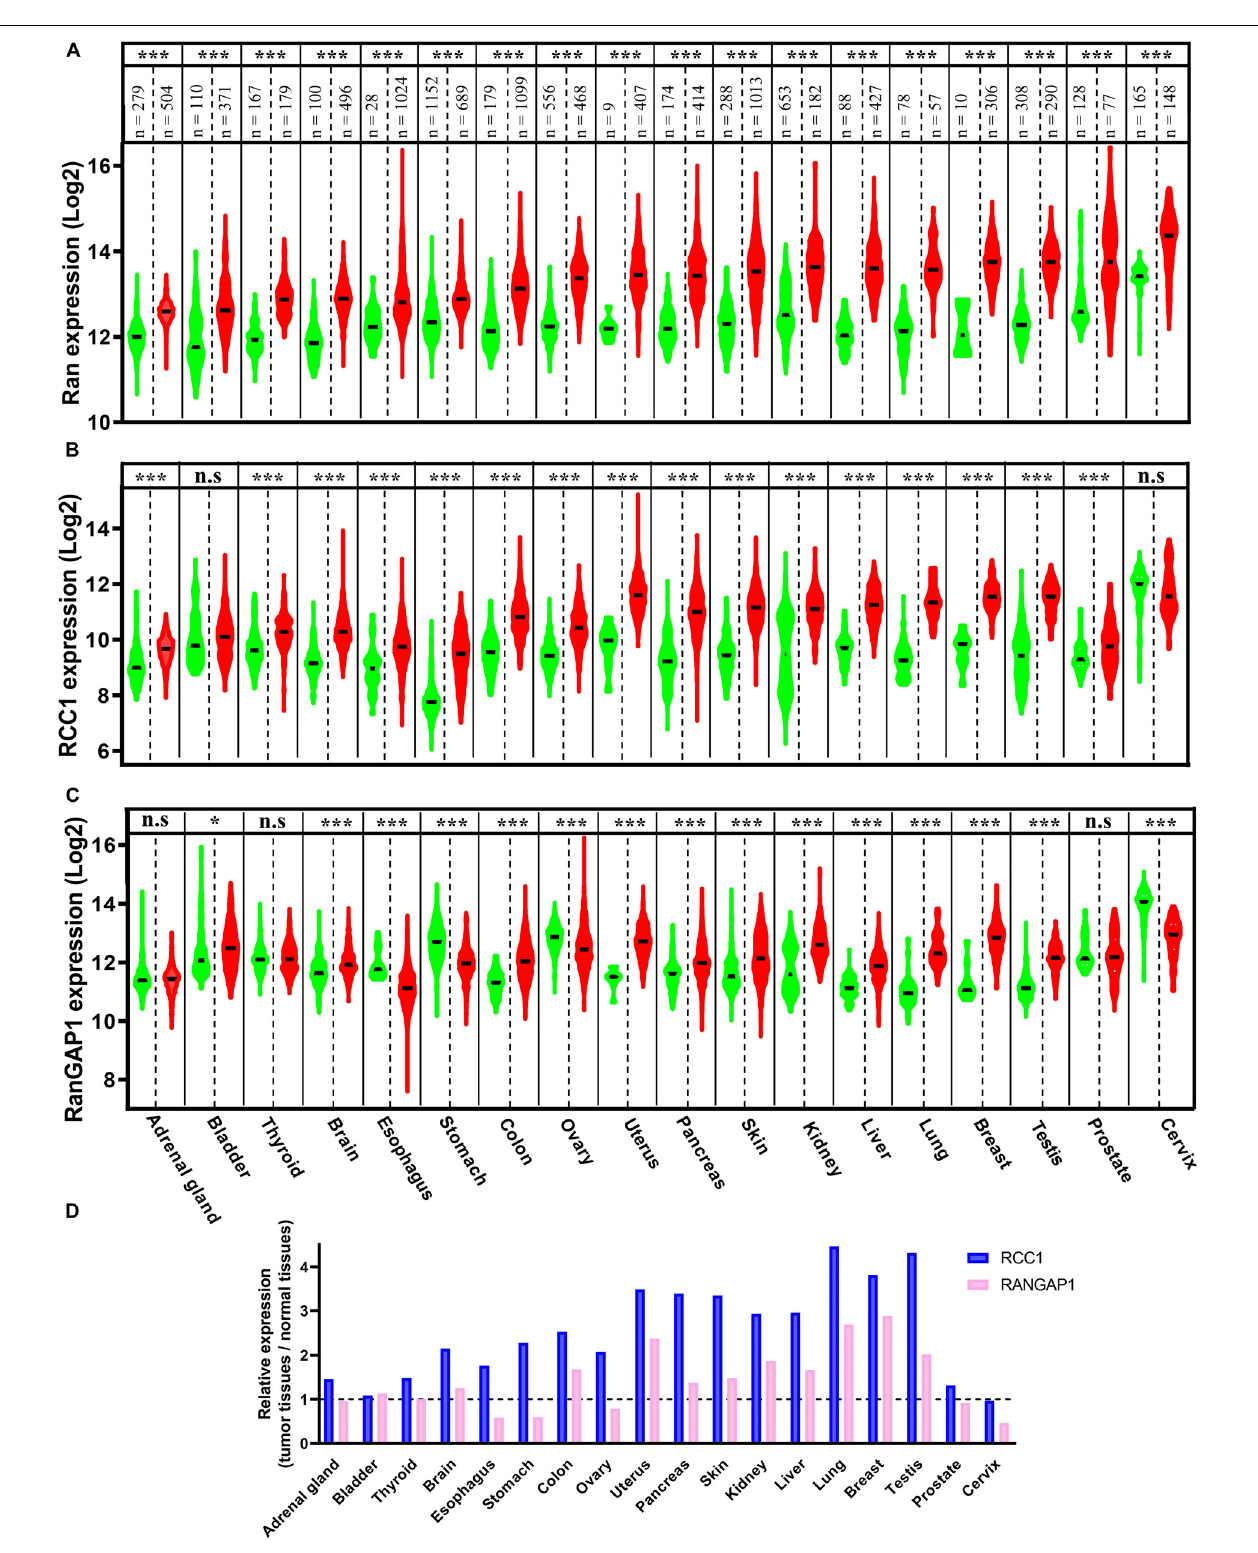
FIGURE 1 | The expression of Ran, Regulator of Chromosome Condensation 1 (RCC1), and RanGAP1 in normal and tumor tissues. The expression of Ran (A) , RCC1 (B) , and RanGAP1 (C) in normal (green) and tumor tissues (red) was extracted from the Xenabrowser web site. * p < 0.05, *** p < 0.001 (Student’s t -test). (D) The expression of RCC1 (blue) and RanGAP1 (pink) in cancer tissues was expressed as the fold change over normal tissues.